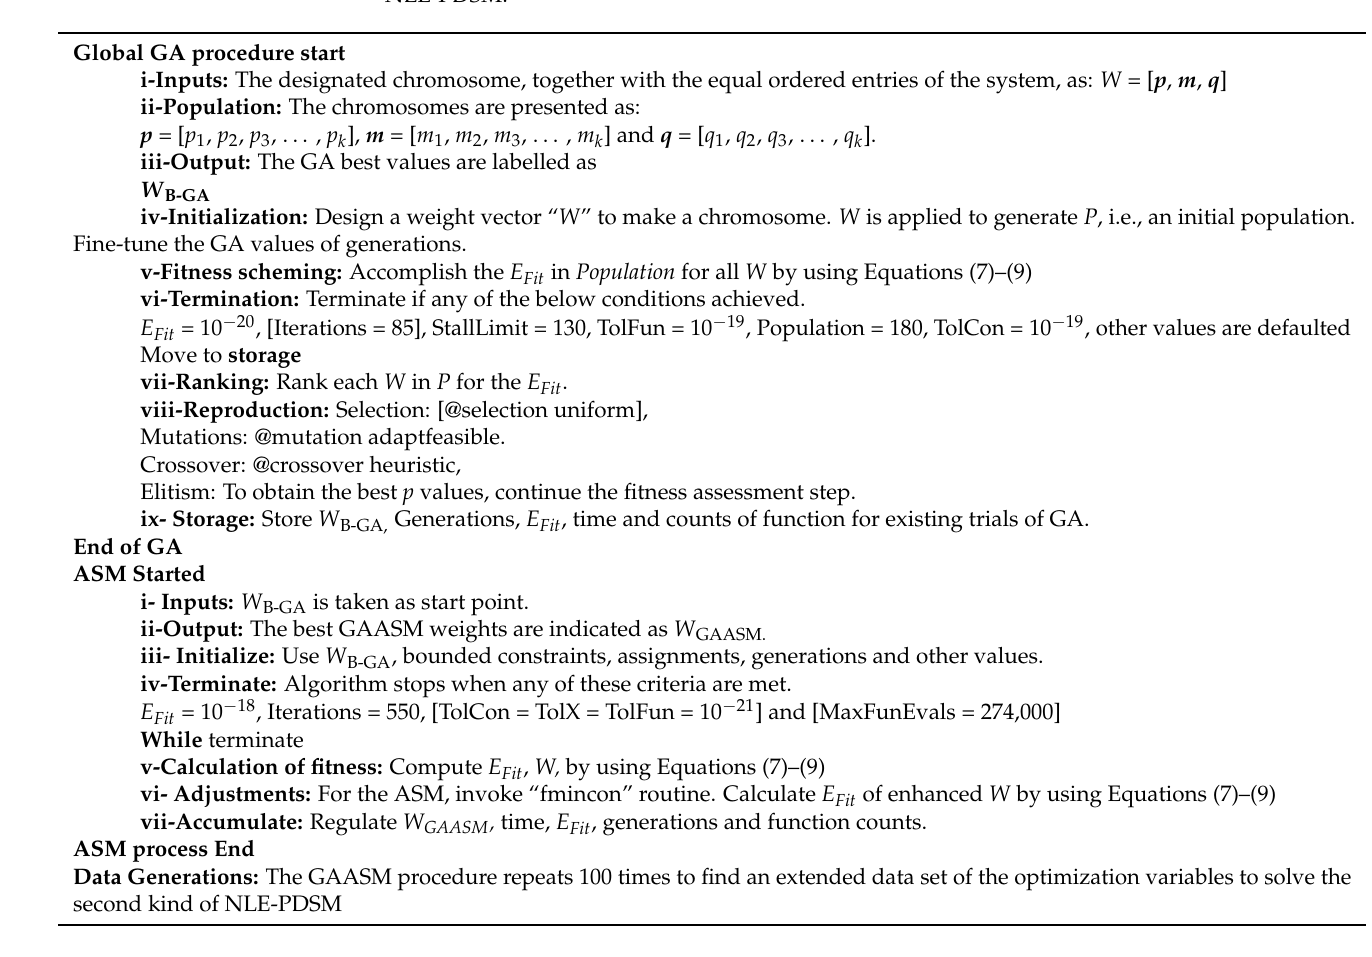
Table 1. Optimization pseudocode for using the ANN-GAASM for solving the second kind of